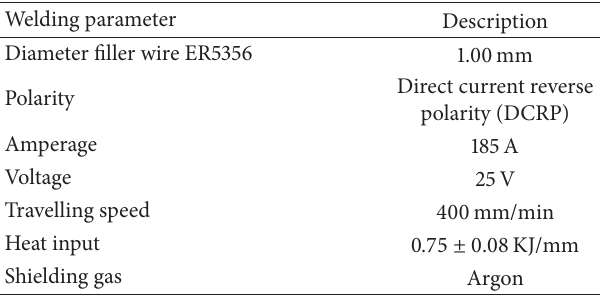
Table 2: Welding parameters used to weld AA6061 Al